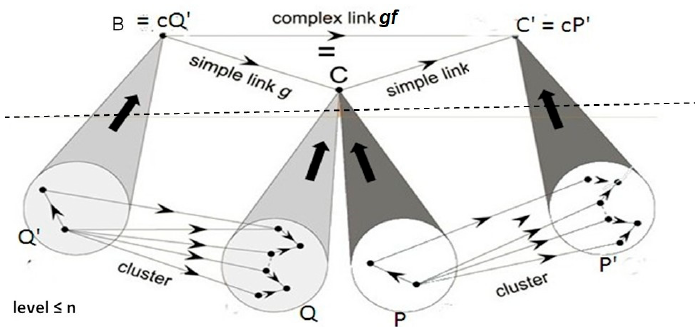
Figure 3. C is an n-multifaceted object which is the colimit of P and of Q. Then the composite of the n-simple morphism from B to C with the n-simple morphism from C to C’ is a complex morphism.